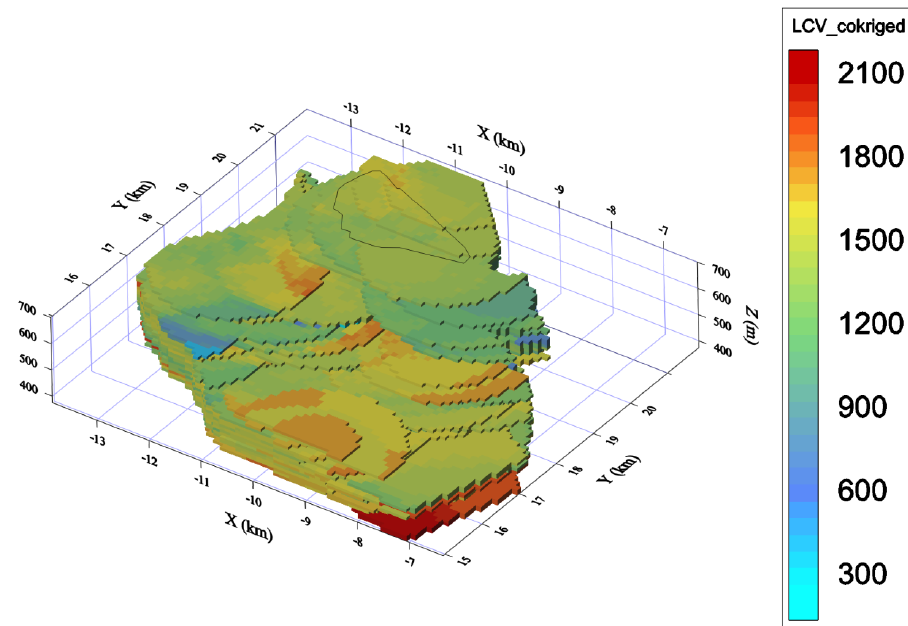
Figure 15. 3D model of LCV (kcal/kg) produced by application of cokriging.